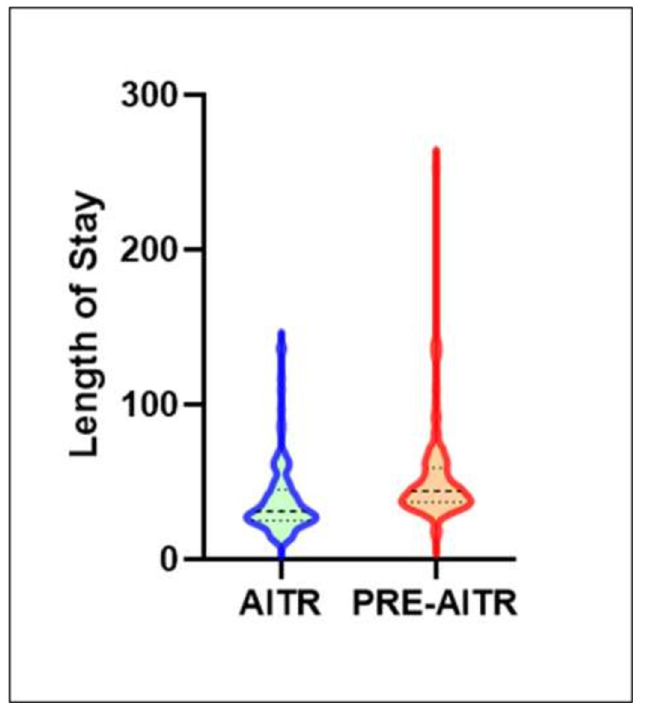
Fig 3. Comparison of length of hospital stay between pre-AITR and